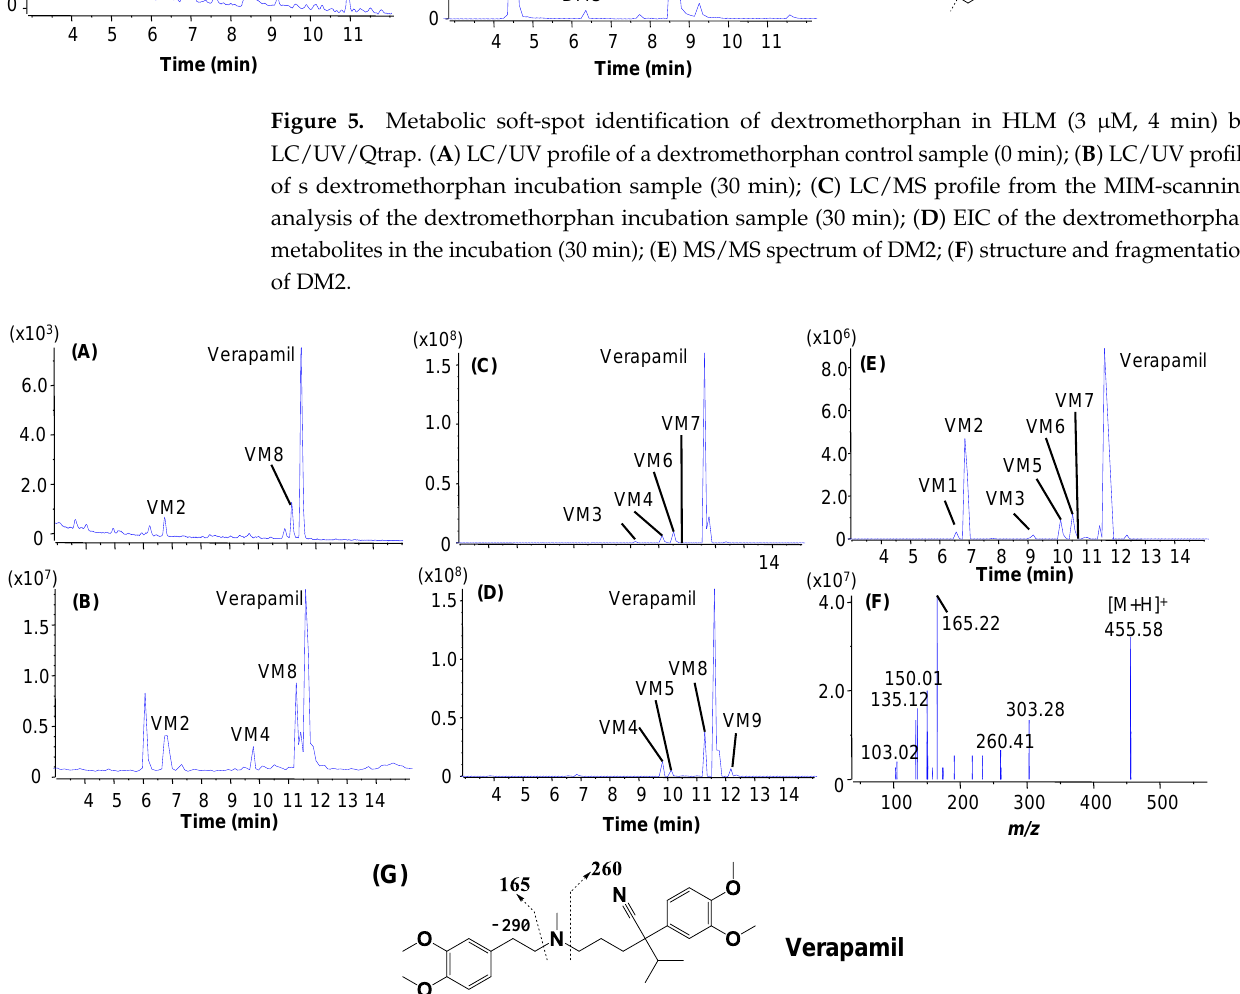
Figure 6. Metabolic soft-spot identification of verapamil (3 µM, 4 min) by LC/UV/Qtrap. ( A ) LC/UV profile; ( B ) LC/MS profile of the MIN scanning; ( C ) LC/MS profile of NLF of 290 Da; ( D ) LC/MS profile of PIF of m/z 165; ( E ) LC/MS profile from PIF of m/z 260; ( F ) MS/MS spectrum of verapamil; ( G ) major fragmentations of verapamil.